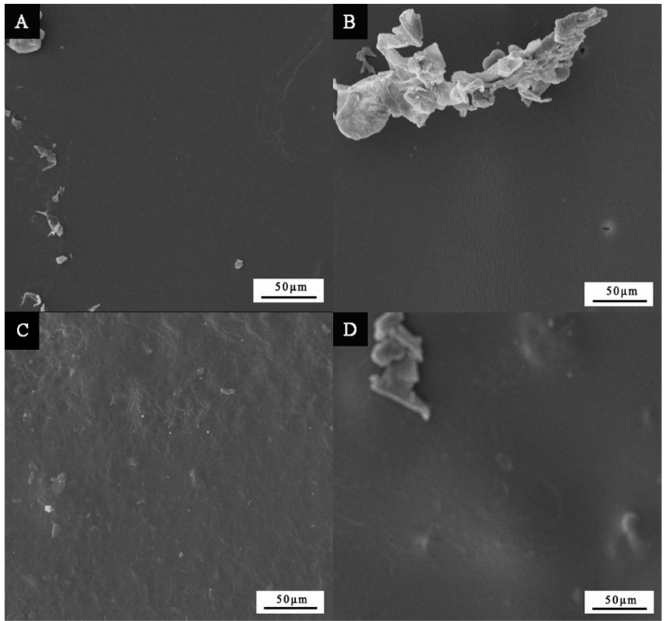
Figure 6. SEM image of paint film: ( A ) without silver antibacterial agents, ( B ) with 4.0% of nano- silver solution, ( C ) with 4.0% of micron silver particles, and ( D ) with 4.0% of urea formaldehyde coated nano-silver solution